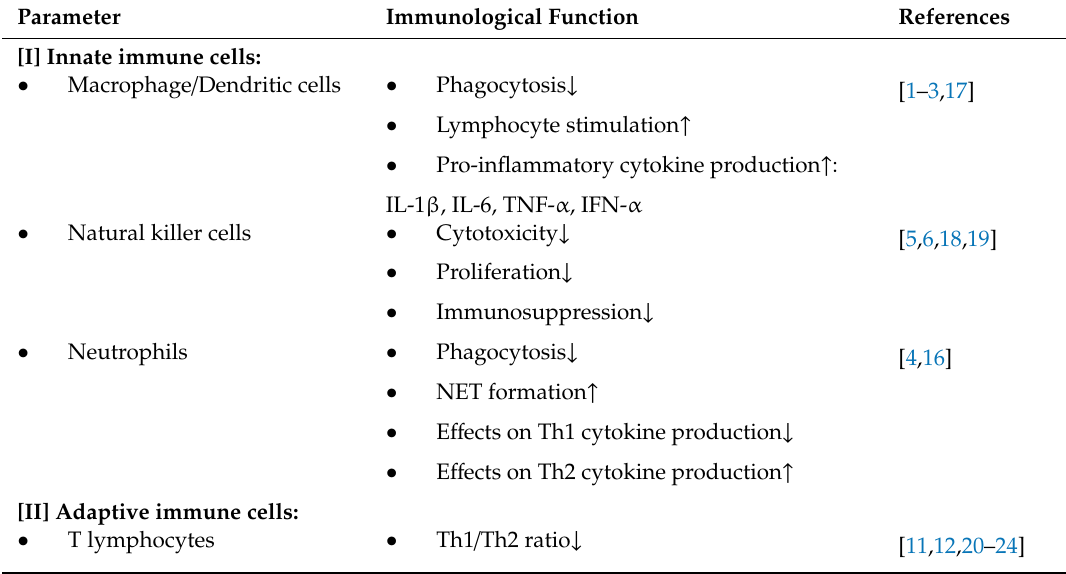
Table 1. Abnormal cell biology and aberrant intracellular signaling of immune-related cells in lupus